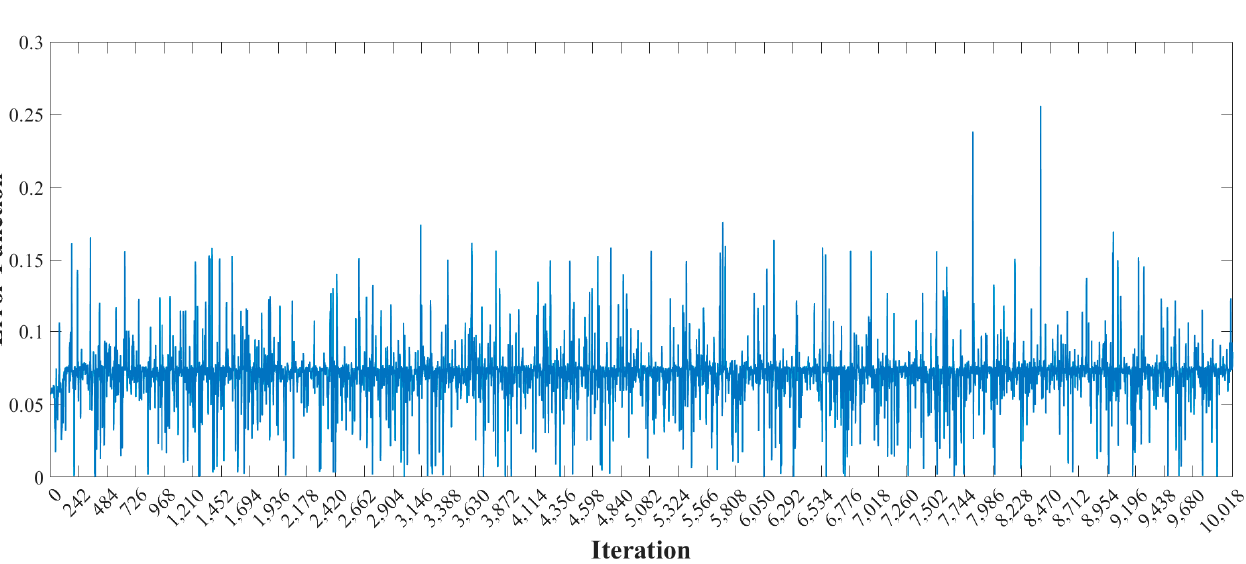
Figure 16. Detail of the trend of the error function showing that the minimum was reached at iteration number 6047.